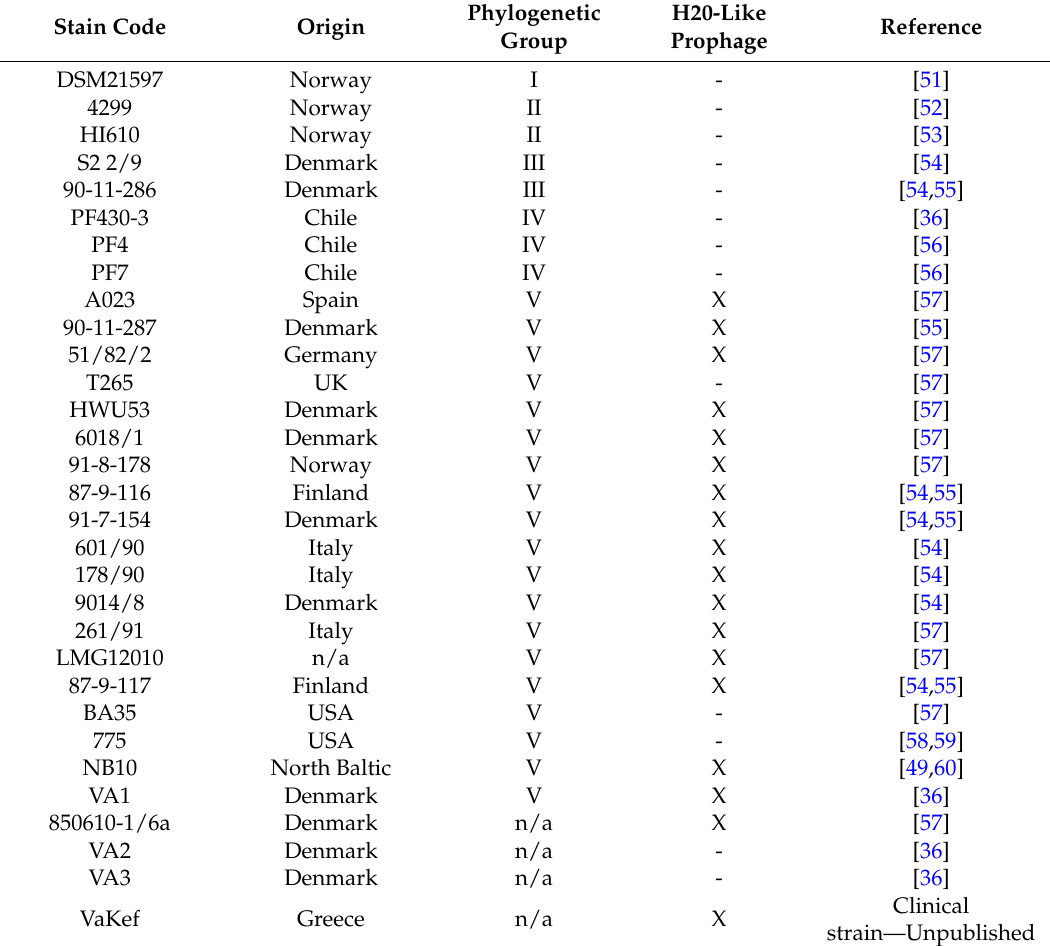
Table 3. Bioinformatic analysis indicates the presence or absence of H20-like prophages in the genomes of 31 pathogenic V. anguillarum strains originated from several different aquaculture producing countries. n/a: not